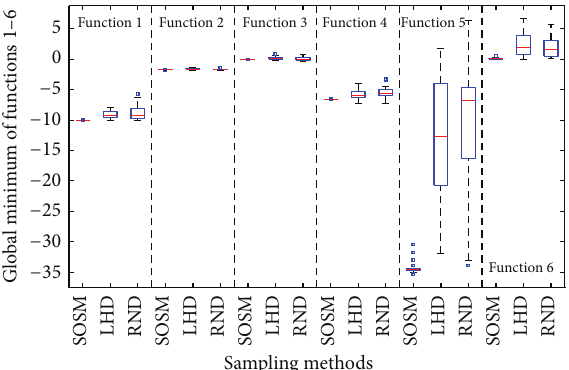
Figure 9: Assessment of metamodels: Global minimum between SOSM and one-stage sampling